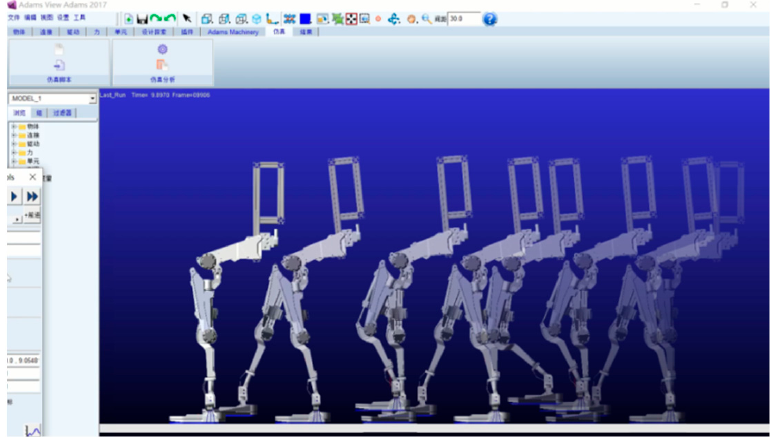
Figure 22. Dynamic simulation of the exoskeleton.